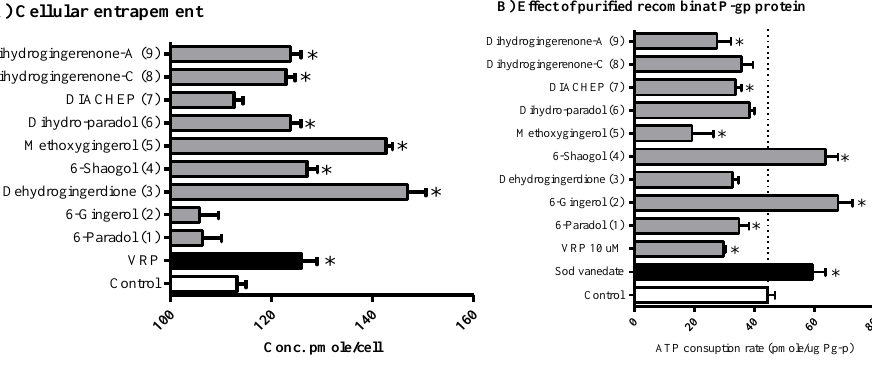
Figure 3. The effect of isolated compounds on the activity of P-glycoprotein efflux pump within CaCo-2 cells ( A ) and in cell free isolated recombinant P-gp protein ( B ). *: significantly different from control group.